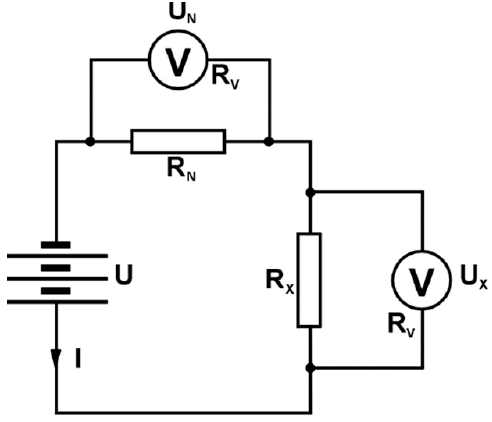
Figure 1. Scheme of the series measuring circuit.